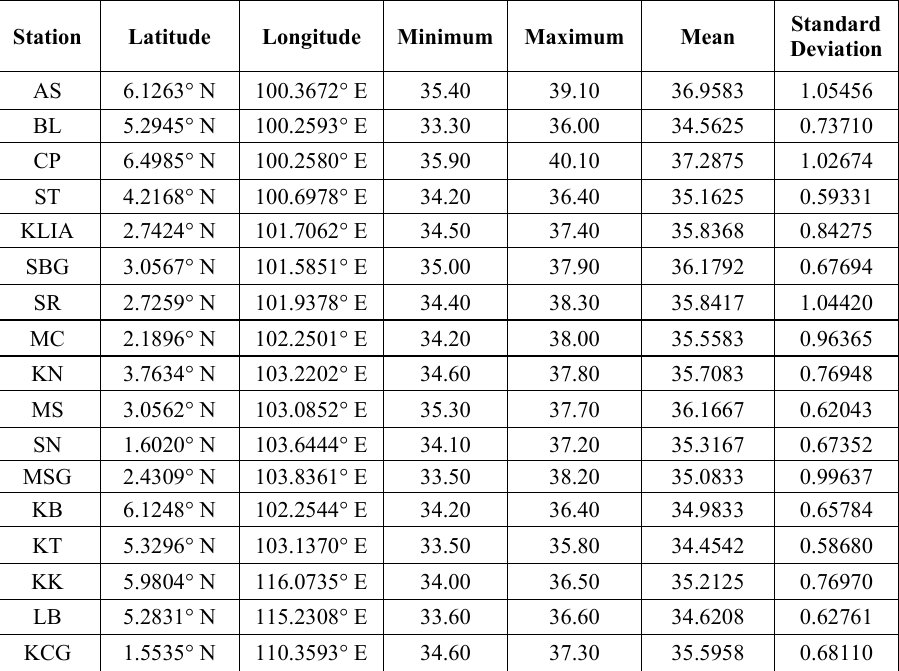
Table 2. Summary of the maximum temperature for seventeen meteorological stations in Malaysia. Station Latitude Minimum